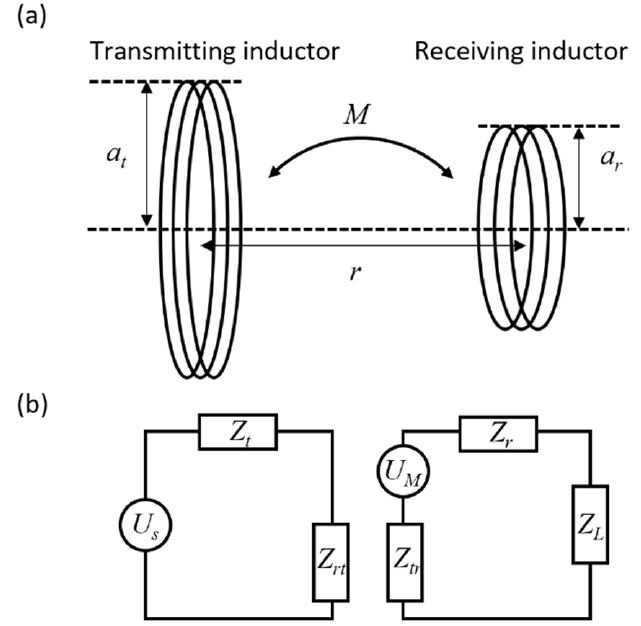
Figure 2. Wireless power transfer based on magnetic induction: ( a ) Magnetically coupled transmitting and receiving inductor. ( b ) Equivalent circuit containing source, mutually coupled inductors, and load (i.e., Joule heater).